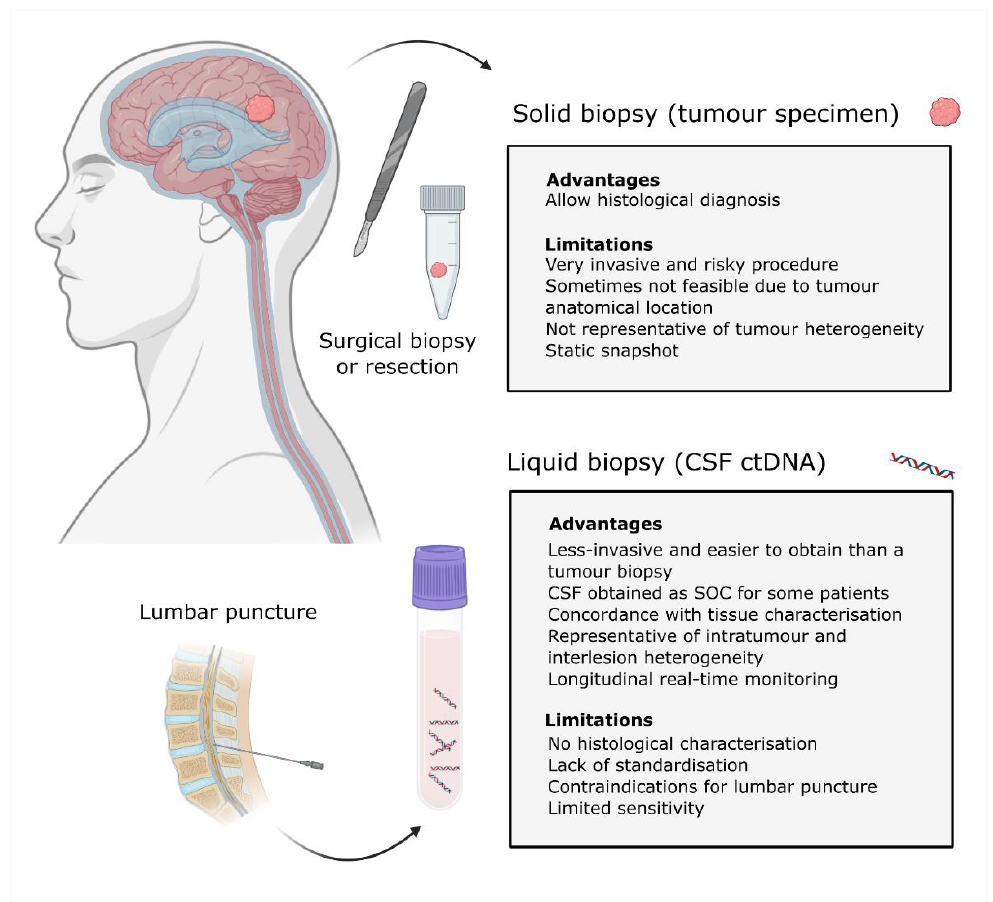
Figure 1. Solid vs. liquid biopsies. Schematic representation of the tumour biopsy and CSF samples obtained from a patient with a CNS malignancy. Advantages and limitations for each methodology are indicated. Definition of acronyms: standard of care (SOC), cerebrospinal fluid (CSF), circulating tumour DNA (cfDNA) and central nervous system (CNS).